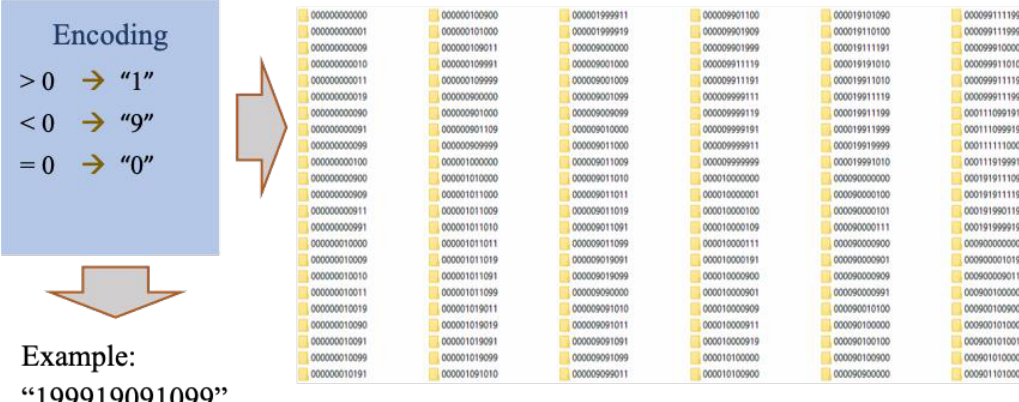
Figure 3. Dictionary classification.